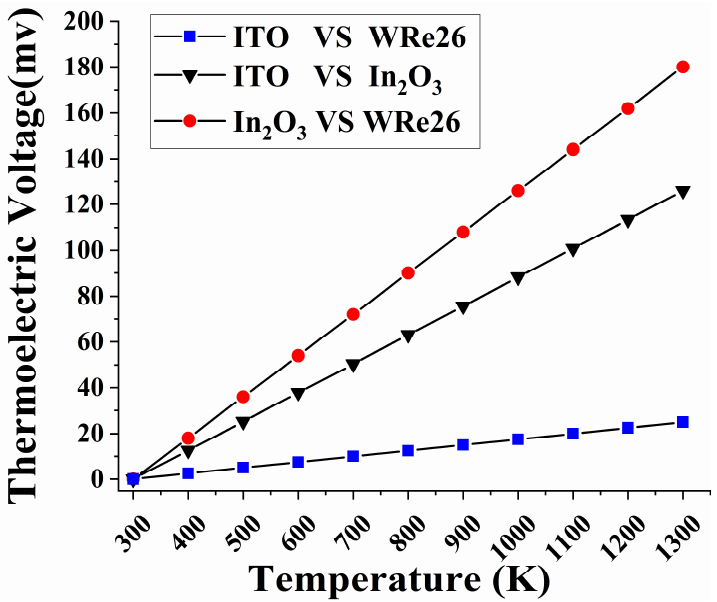
Figure 3. Thermoelectric voltage of three combinations simulation results.